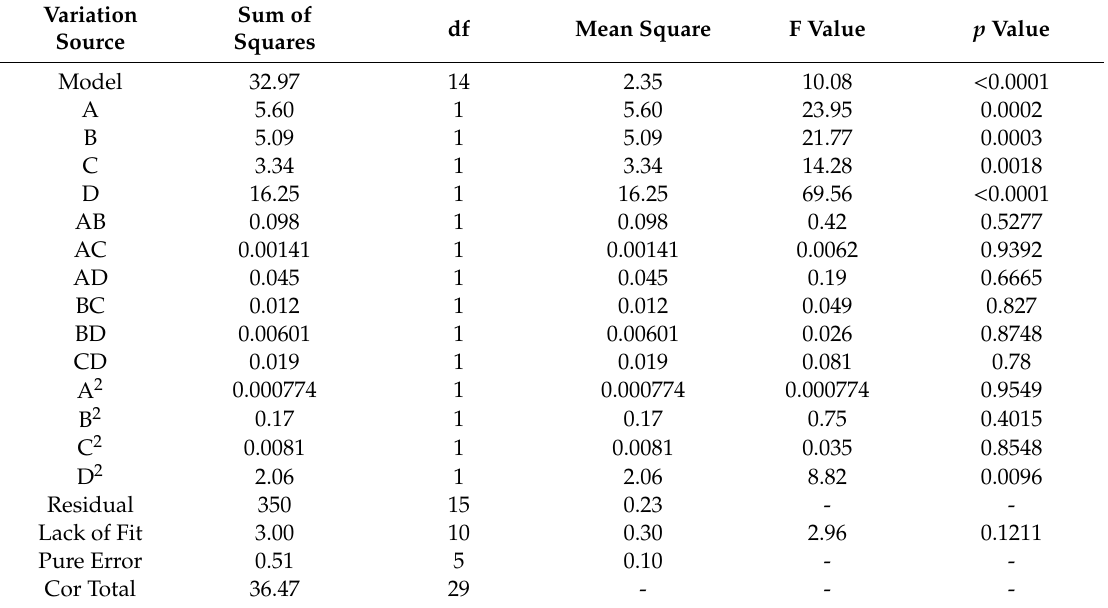
Table 7. Analysis of variance of the 28-d UCS regression